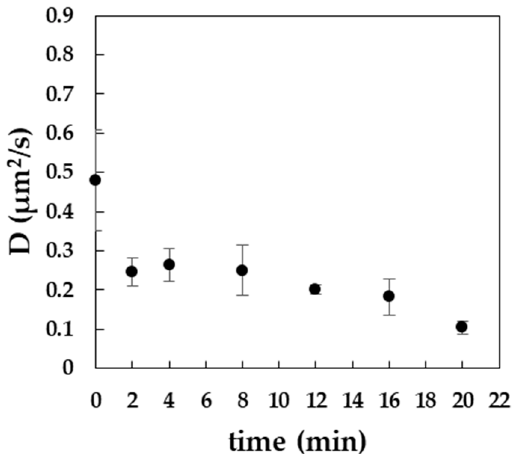
Figure 3. Diffusion constant of Abberior Star 488 PEG cholesterol probe (ASP-Chol) in the plasma membrane of B16-F10 cells upon exposure to 10 mM M β CD for the indicated time.